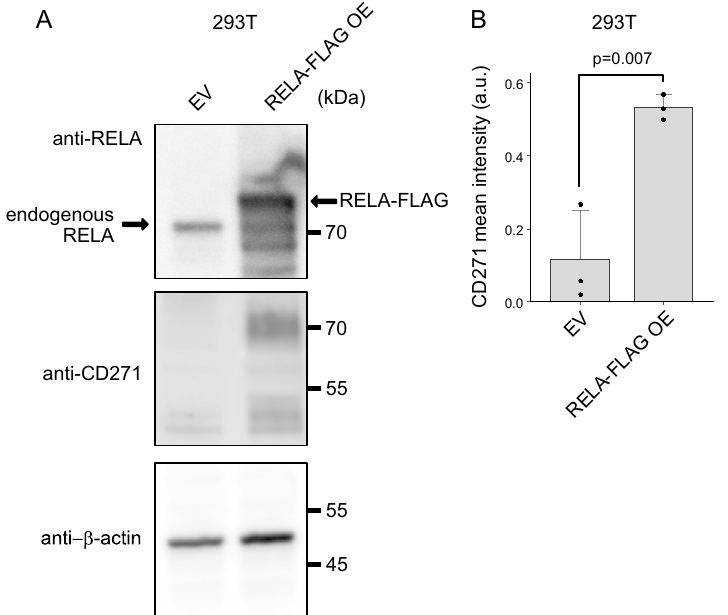
Figure 3. RELA overexpression promotes CD271 expression. ( A ) 293 T cells were transfected with a p3xFLAG- CMV14-RELA, and levels of the indicated proteins were determined by western blot using indicated antibodies. ( B ) CD271 expression following p3xFLAG-CMV14-RELA overexpression according to flow cytometry. OE,